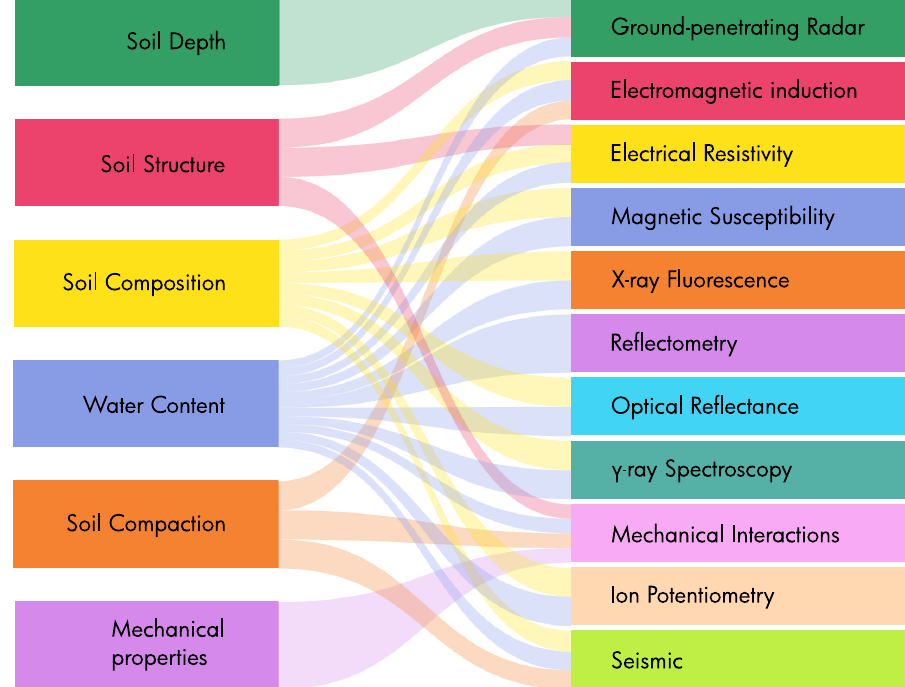
Figure 3. Main proximal sensors for precision